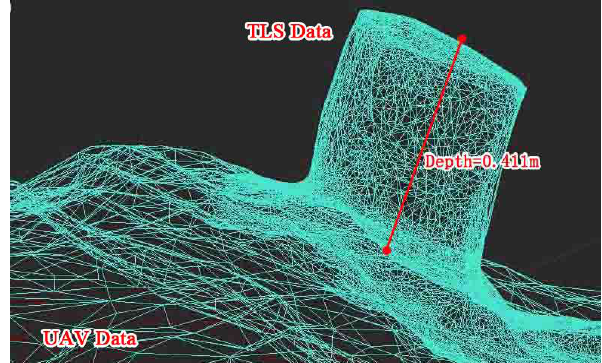
Figure 7. Depth of the No. 12 hole in the Chiya Plank Road in 3Ds Max.